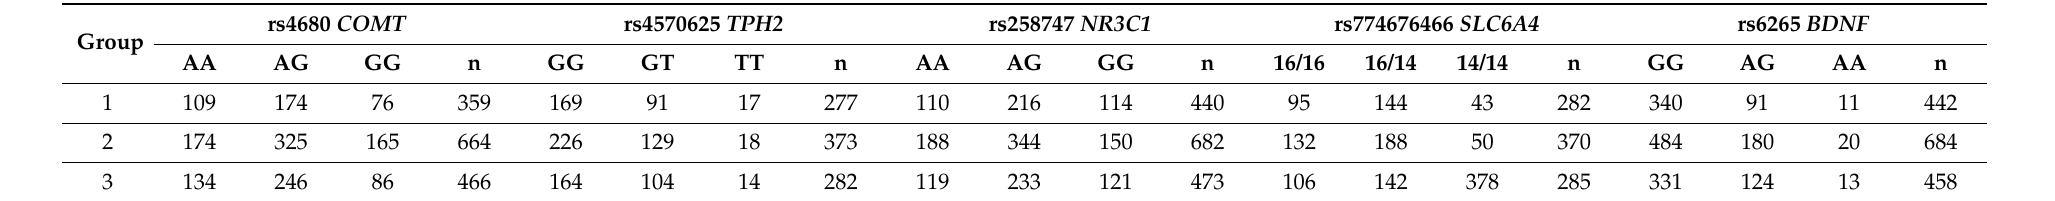
Table 3. Numbers of genotype carriers for rs4680, rs4570625, rs258747, rs6265, and the rs774676466 indel in the three groups of adolescents (1: born in